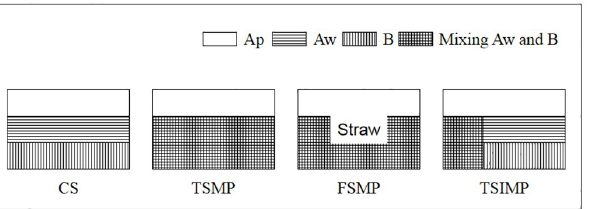
Fig 2. Schematic diagram of the four